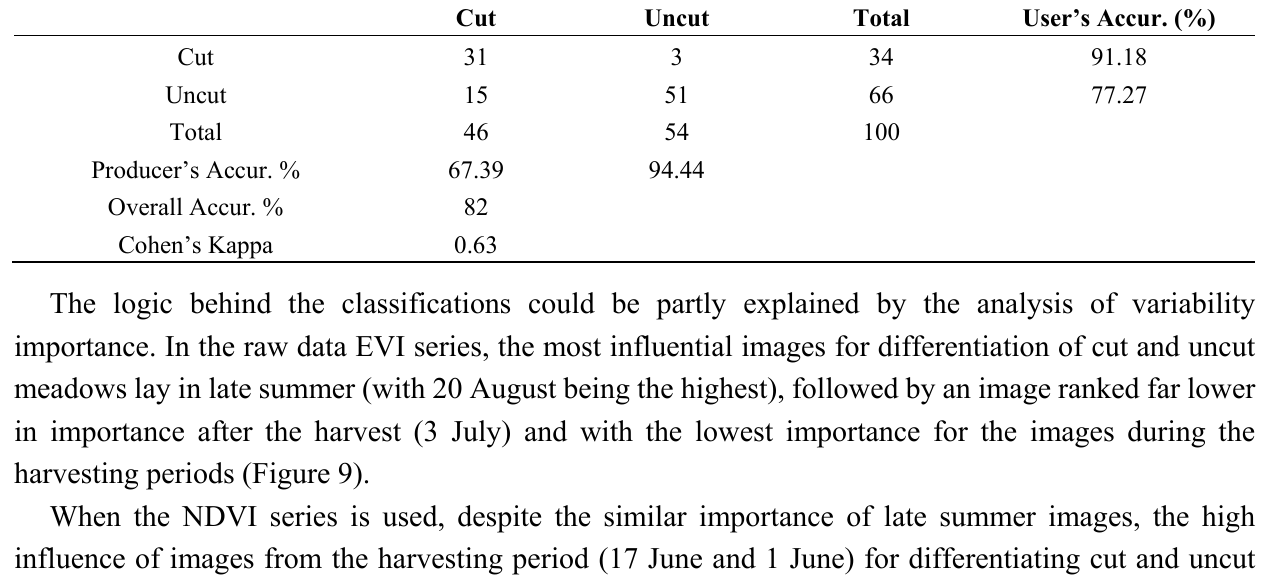
Table 8. Confusion matrix and accuracies of first difference EVI data set (16 May to 5 September).